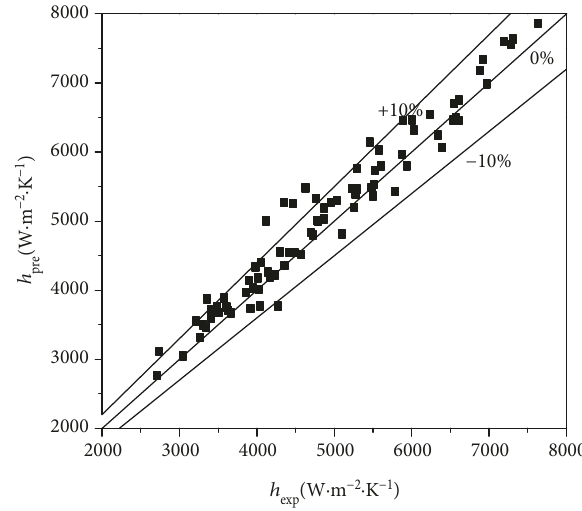
Figure 3: Comparing the GRNN network prediction result with the experimental results.